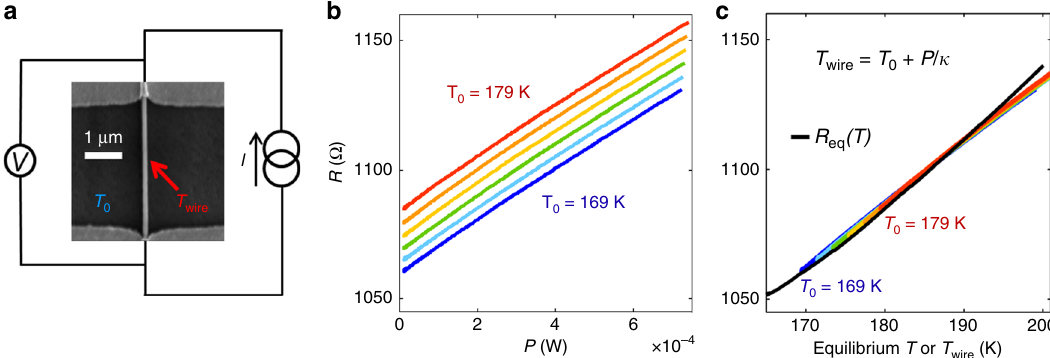
Fig. 1 Determination of temperature change due to applied power in VO x nanowires. a SEM image of a V 2 O 3 nanowire contacted by two Ti/Au pads (top and bottom) and schematic of the measurement setup. T 0 and T wire are the temperatures of the substrate and the nanowire, respectively, which differ due to the applied power. b Resistance vs. power curves measured above the IMT temperature in the fully metallic state of a V 2 O 3 nanowire at T 0 between 169 and 179 K (blue to red). c Resistance vs. T wire (colored lines) derived from b using Eq. (2) with a single fi tting parameter κ = 24 μ W K − 1 for all curves (colored). The black curve shows the resistance vs. stage temperature at equilibrium, R eq ( T ). The horizontal T axis refers both to the stage temperature during the equilibrium (low power) measurement and T wire .